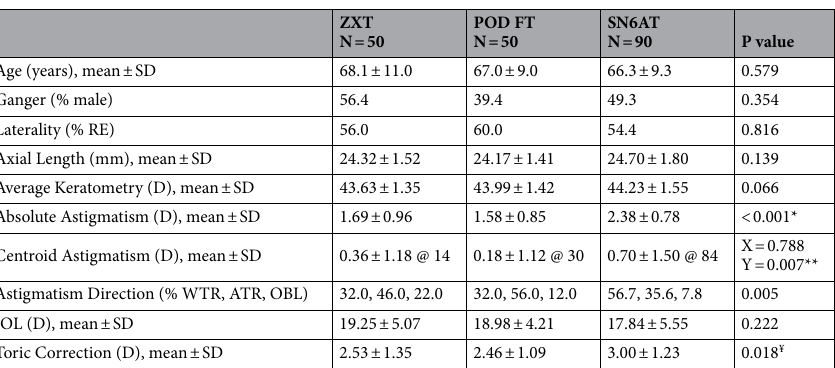
Table 1. Patient’s demographic, biometric data, and the implanted TIOLs. Biometry measured by IOL-Master 500. RE right eye, D diopters, WTR with-the-rule (60°–120°), ATR against-the-rule (0°–30°, 150°–180°),